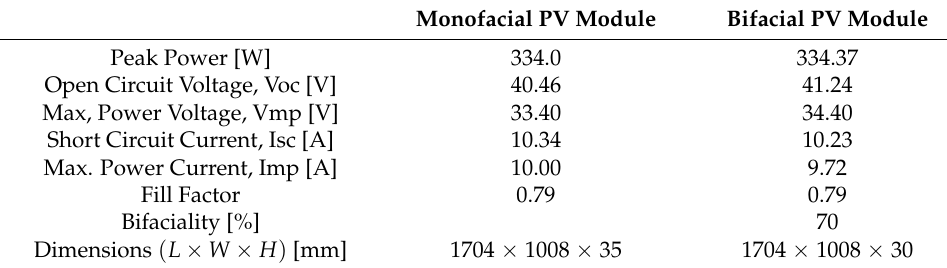
Table 3. Electrical characteristics of the simulated